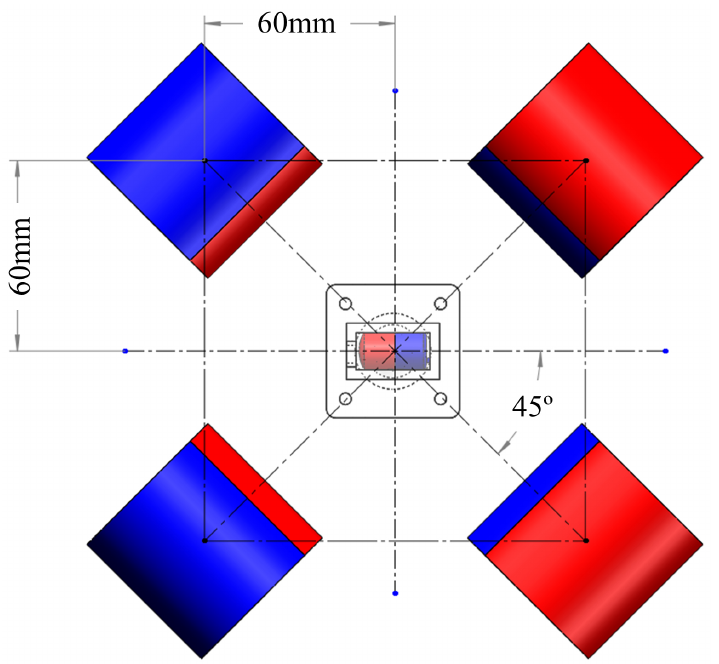
Figure 13. Relative positions of the EPM and the IPM in error analysis experiments. Experiments were performed to select appropriate thresholds for proposed alignment